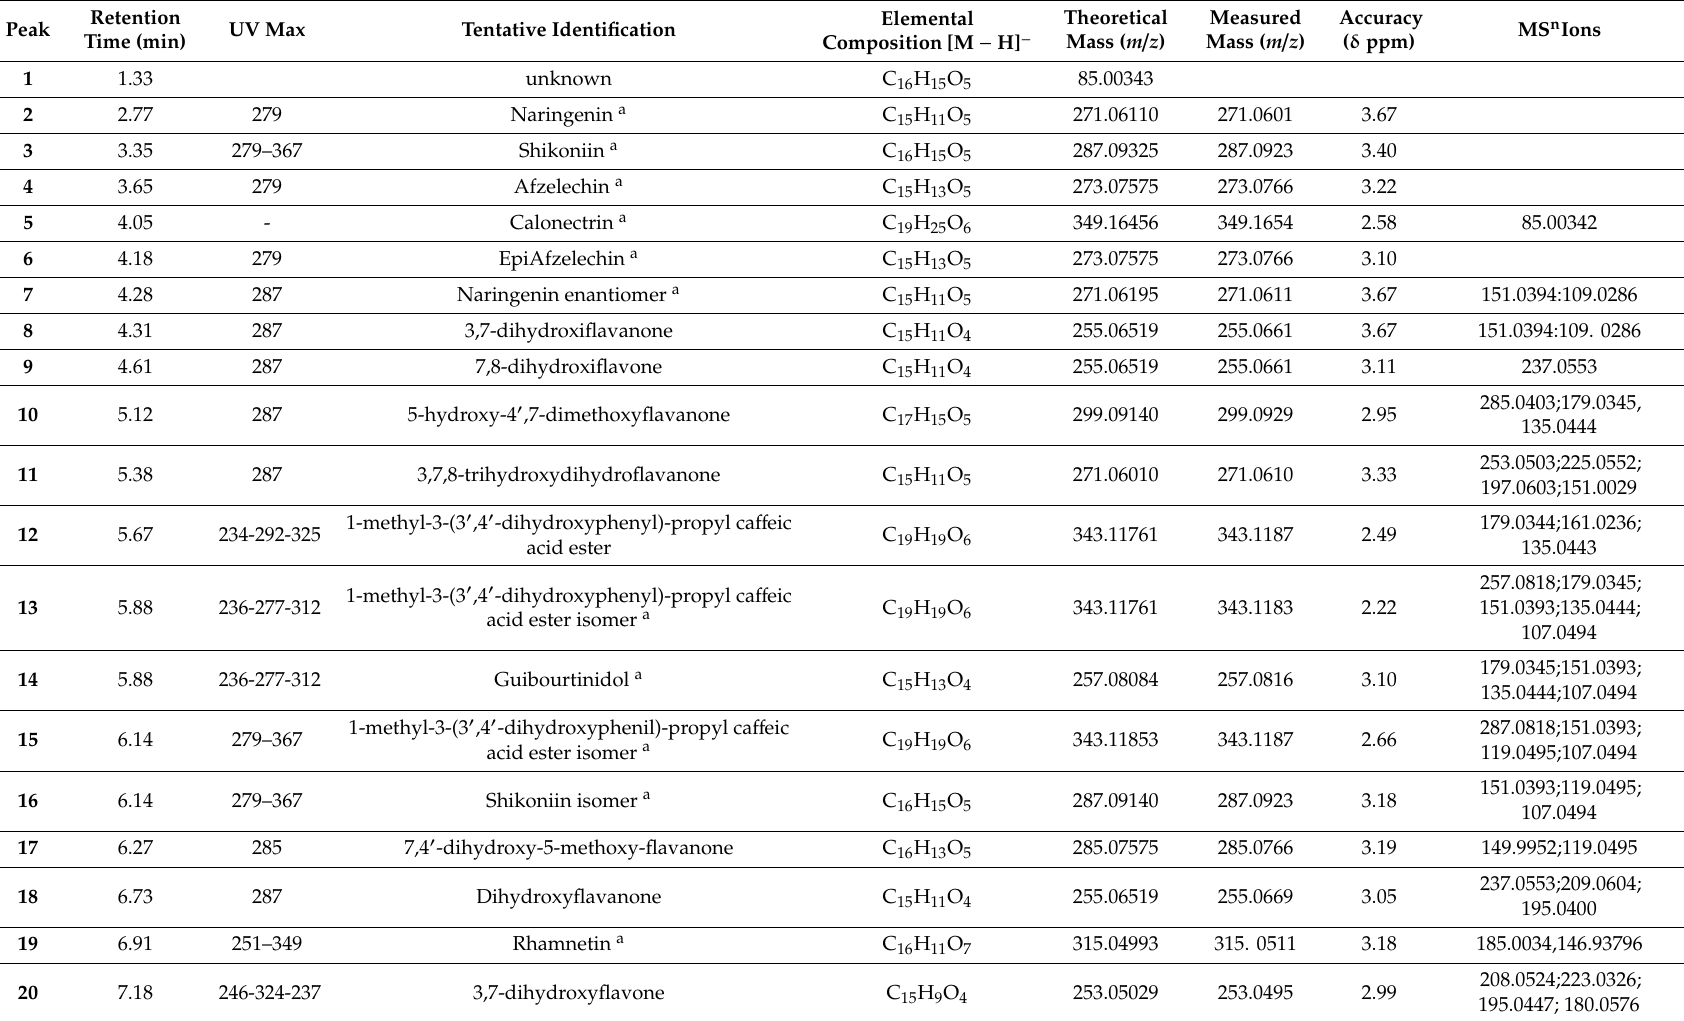
Table 1. Resolution UHPLC-PDA-Q-Orbitrap identification of biomolecules from ZpRe